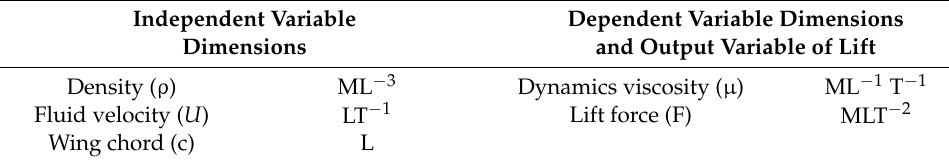
Table 4. Independent, dependent, and output variables of